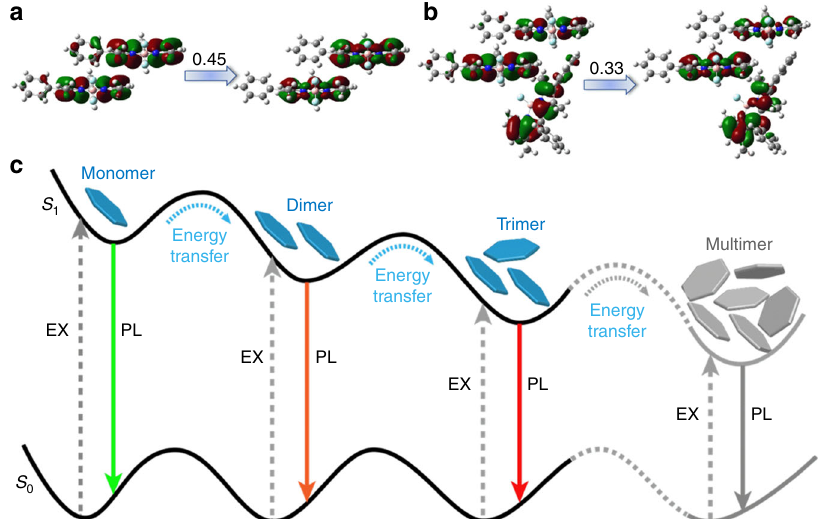
Fig. 5 Theoretical calculations for mechanistic investigation. Calculated NTOs of BDP1 a dimer-1 and b trimer-1. c Schematic illustration of the proposed Domino-like energy transfer and subsequent multiple emissions in solid state